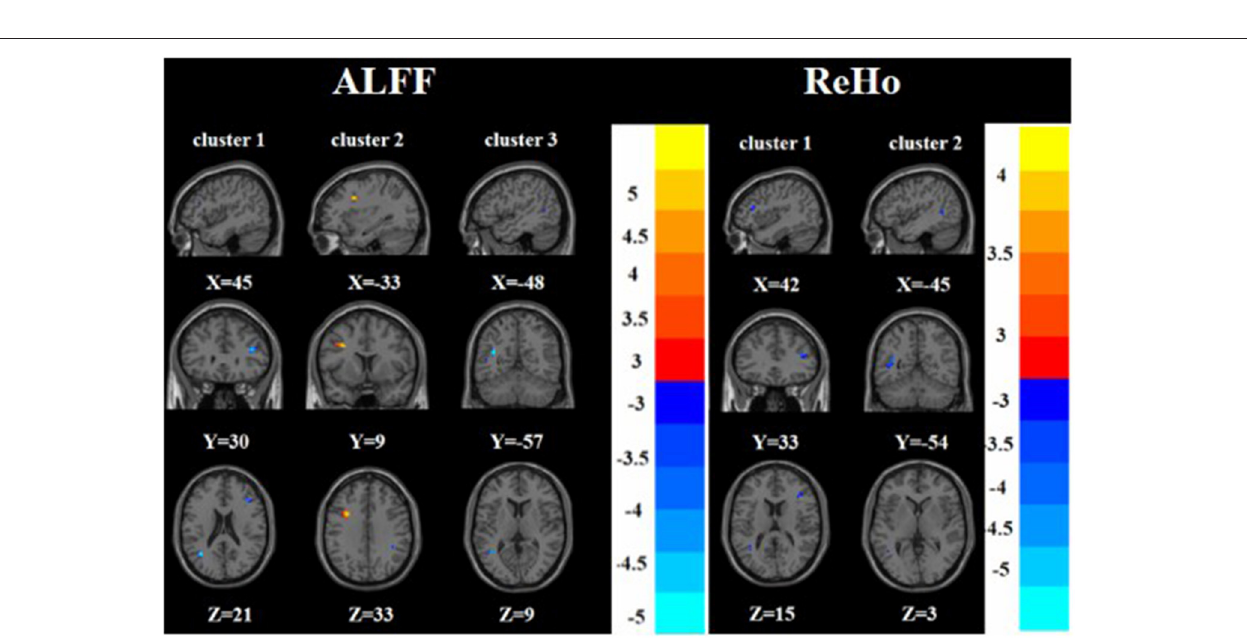
FIGURE 3 | Brain regions with abnormal ALFF (left) and ReHo (right) between TRD group and nTRD group based on post hoc T -tests. The color bars indicate the T -value.